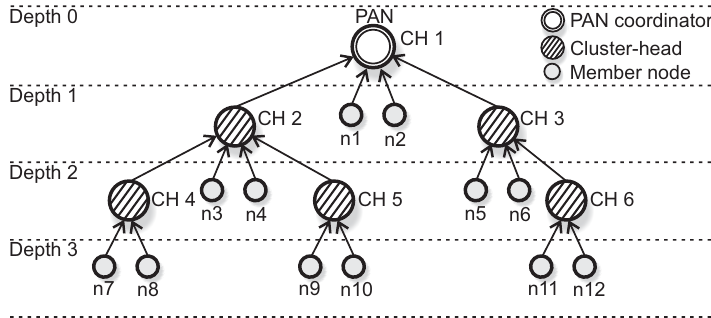
Figure 11. Cluster-tree network composed of 6 cluster-heads and 12 leaf